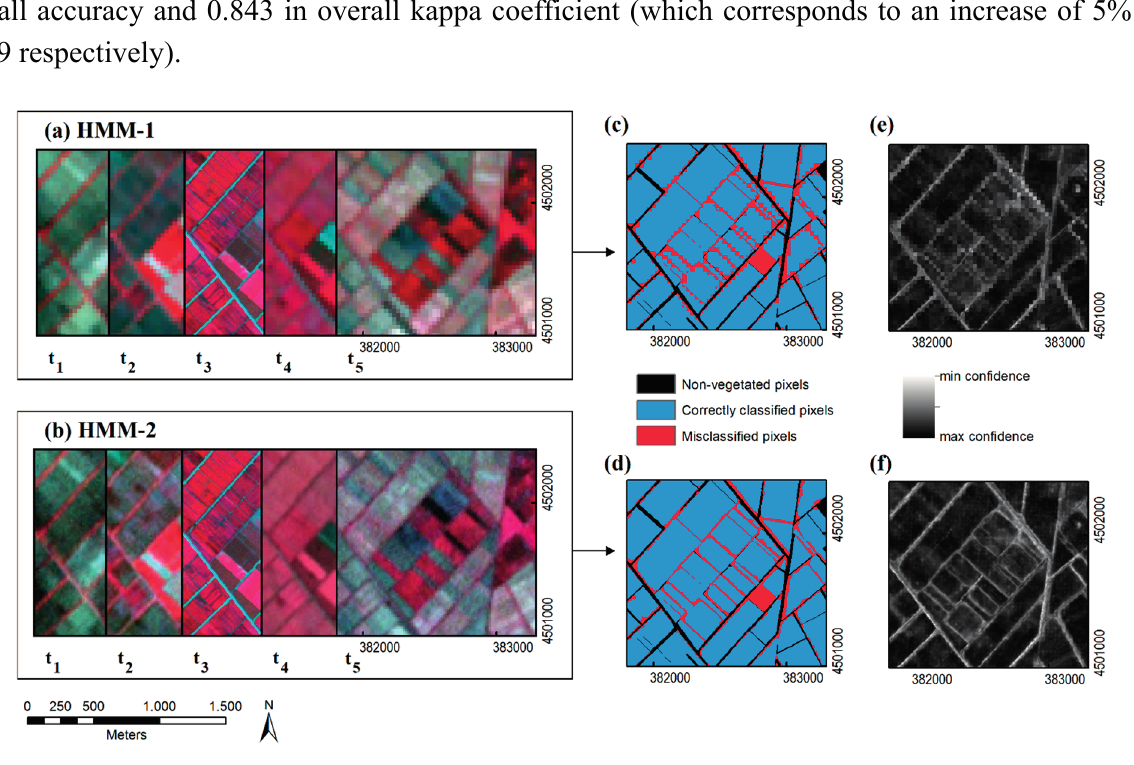
Figure 8. Visual assessment of the classification results obtained from experiment HMM-1 considering the original ETM+ and RapidEye images ( a ) and from experiment HMM-2 considering the pan-sharpened ETM+ and RapidEye images ( b ). HMM-1 experiment resulted to more extended classification errors along the parcel’s borderline ( c ) and the respective classification errors ( d ) compared to lower classification confidence ( e ) and confidence score ( f ) obtained from experiment